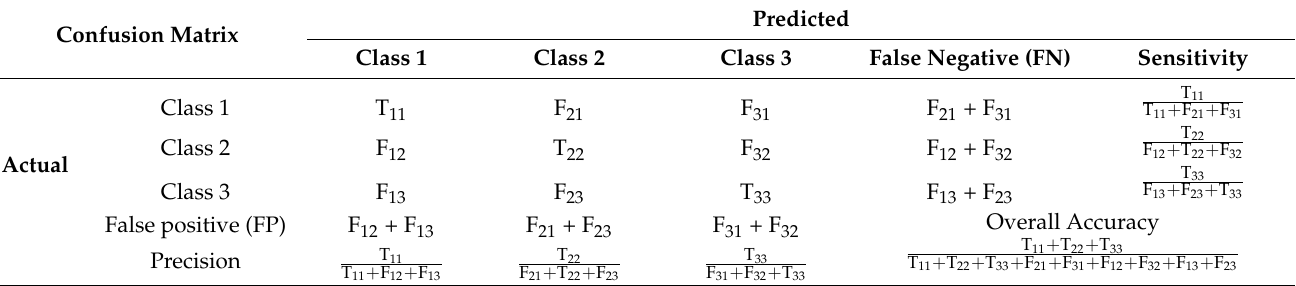
Table 3. Confusion matrix for the Bayesian